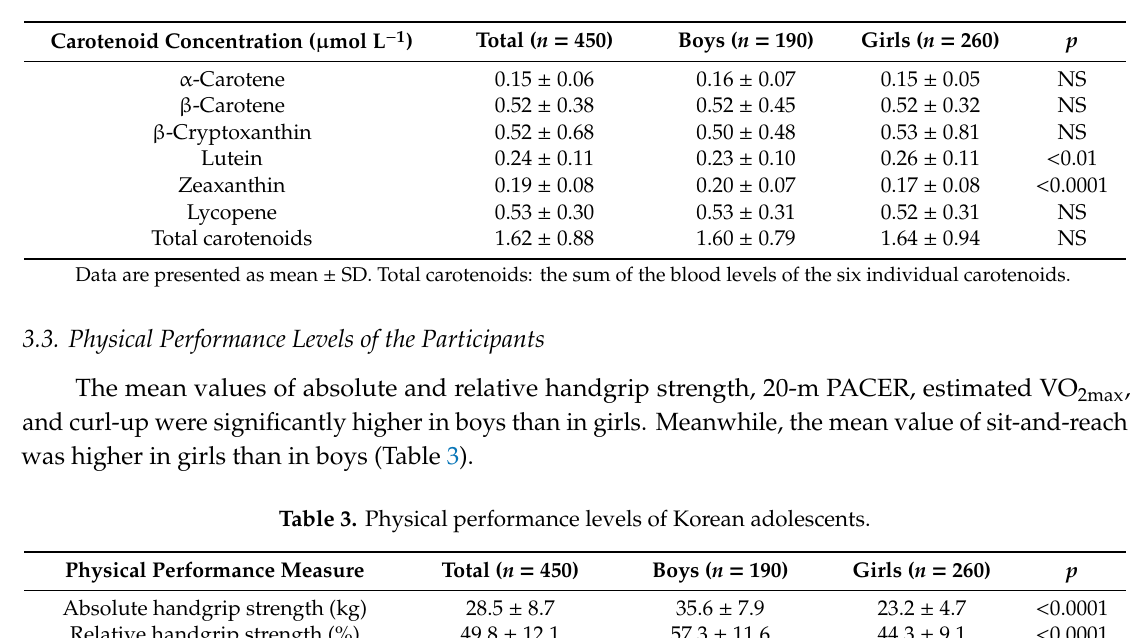
Table 2. Blood carotenoid level of the adolescents.